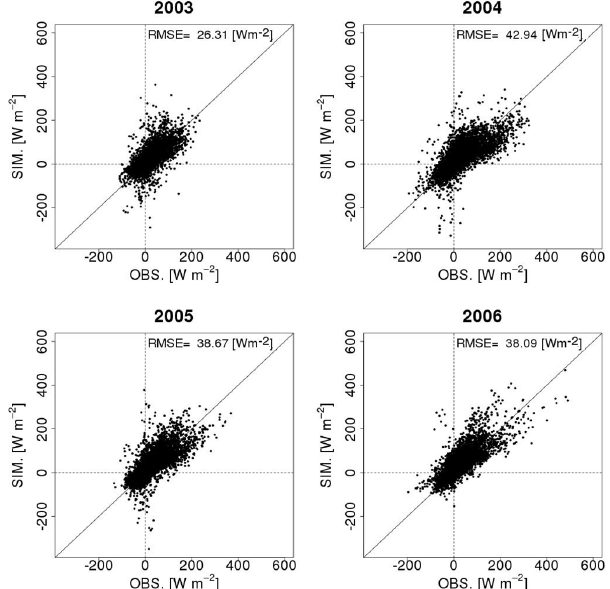
Figure 10. Comparison of half-hourly SHF between simulations and observations.